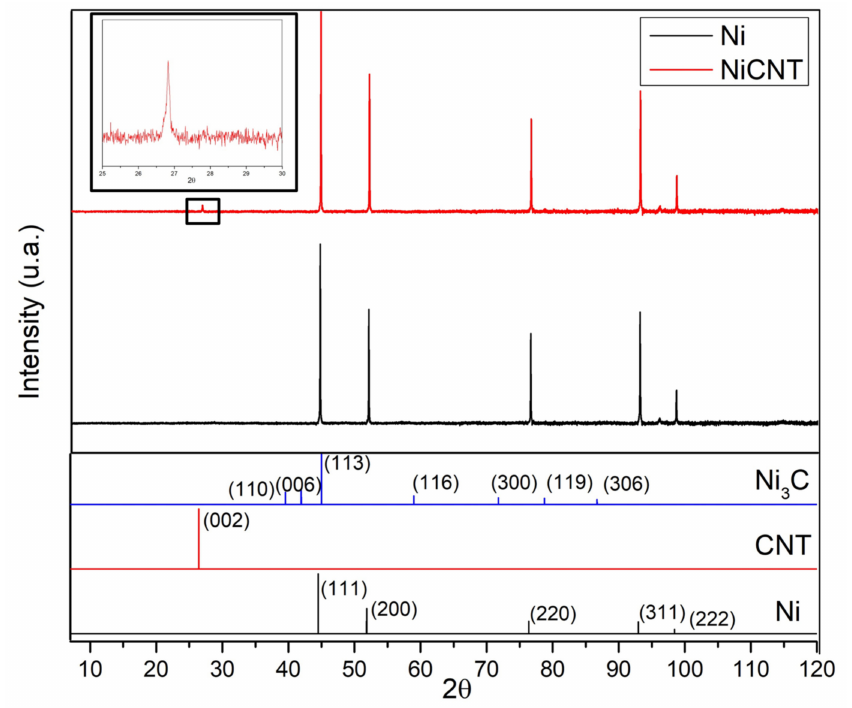
Figure 6. XRD patterns of Ni and Ni-CNT nanocomposite and XRD peaks for, Ni, CNTs, and Ni 3 C phases.